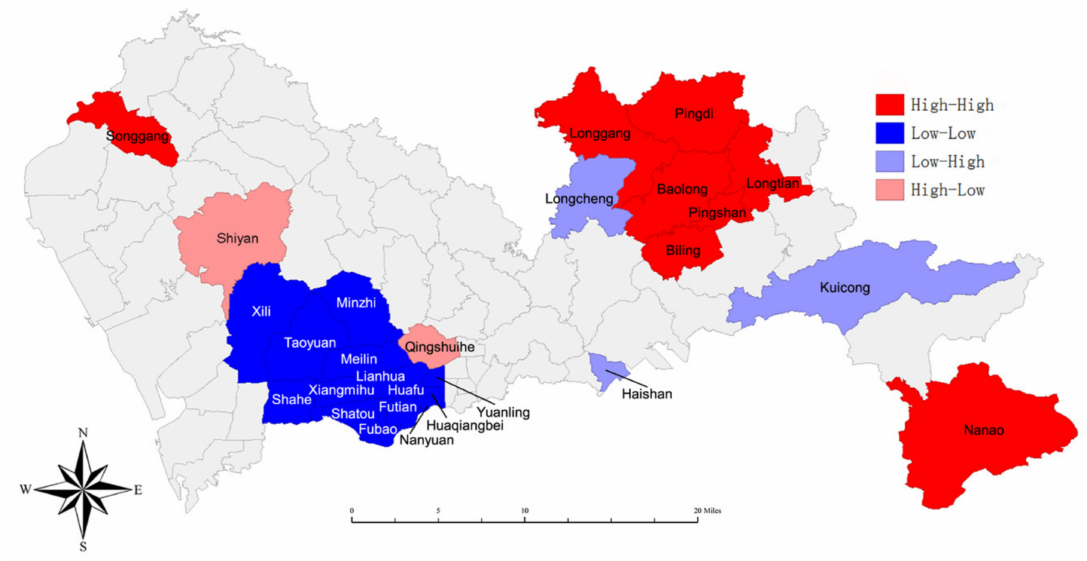
Figure 5. Local hotspot map for crude incidence of lung cancer in Shenzhen, 2008–2018. (Note: high–high = areas with high incidence; low–low = areas with low incidence; low–high = a low incidence area surrounded by high incidence areas; high–low = a high incidence area surrounded by low incidence